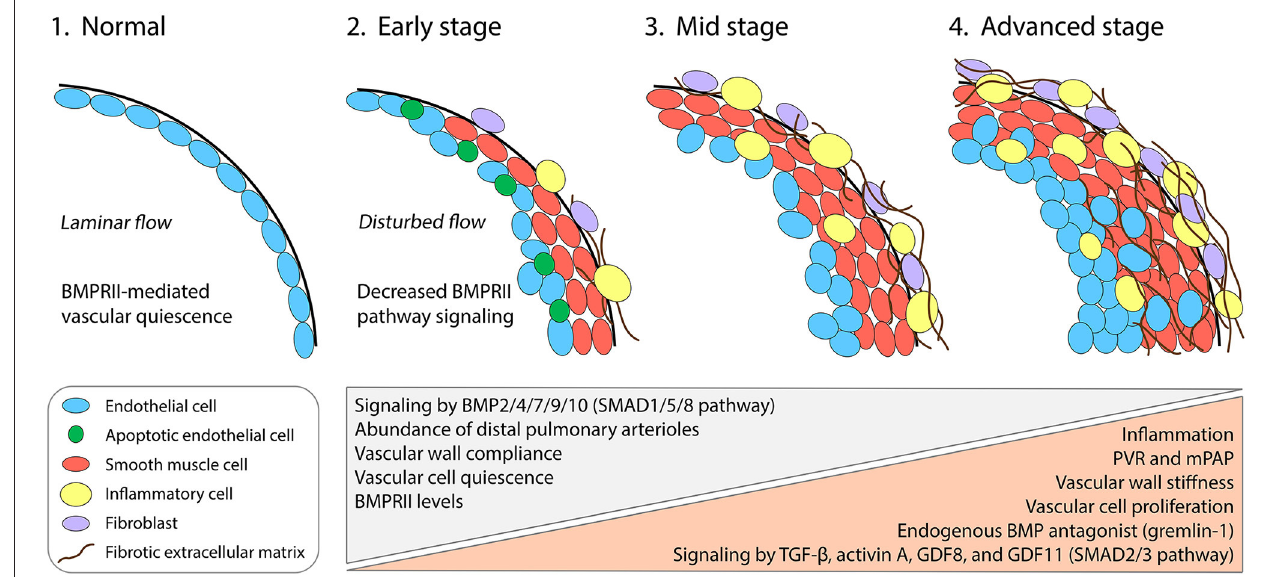
FIGURE 1 | Cellular, molecular, and biomechanical progression of PAH in the pulmonary arterial wall. Under normal conditions, the pulmonary distal arterioles comprise an intimal monolayer of ECs and are largely devoid of a medial layer with SMCs. Laminar blood flow patterns promote BMPRII-pathway signaling in ECs and maintain vascular quiescence (1). Genetic mutations or combined insults lead to insufficient BMPRII levels and SMAD1/5/8 signaling in multiple vascular cell types. Early events during PAH pathogenesis include the onset of vascular wall stiffening and inflammatory responses, including infiltration by diverse inflammatory cell types. Apoptotic ECs appear early but are progressively replaced by apoptosis-resistant and hyperproliferative ECs, which ultimately form disorganized neointimal lesions (2–4). SMAD2/3 pathway-activating ligands including TGF- β , activin A, GDF8, and GDF11 become upregulated and contribute to arterial remodeling. Gremlin-1, a key pathogenic protein in PAH, reduces BMPRII-pathway signaling by antagonizing specific BMPs. SMCs accumulate in the medial layer, causing distal muscularization. Fibroblasts in the adventitial layer become activated and synthesize fibrotic extracellular matrix. PVR, pulmonary vascular resistance; mPAP, mean pulmonary arterial